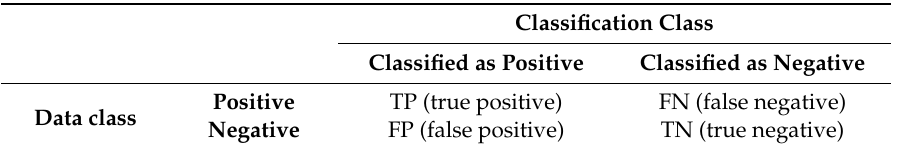
Table 3. Definition of the binary confusion